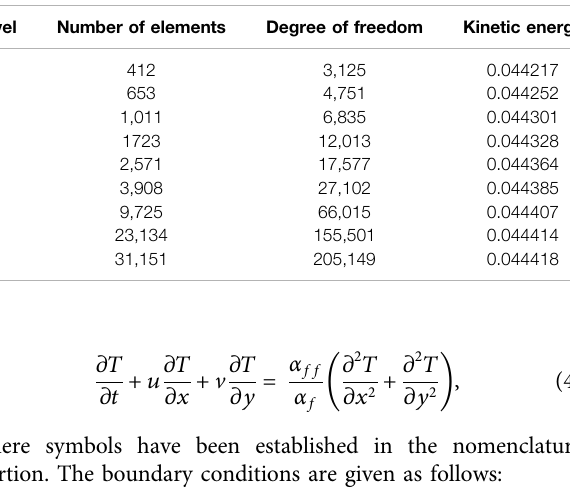
TABLE 2 | Grid convergence test for kinetic